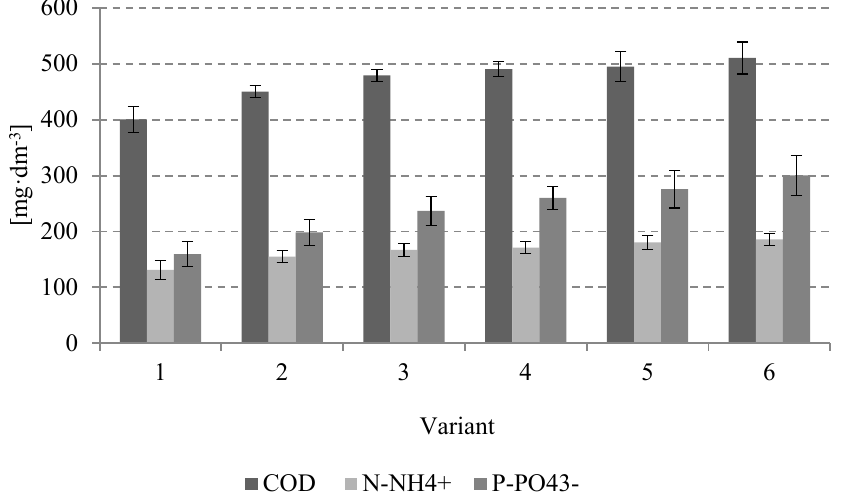
Figure 1. Changes in the concentrations of organic and biogenic compounds in DSS supernatant after solidified carbon dioxide (LTC − SCDO).